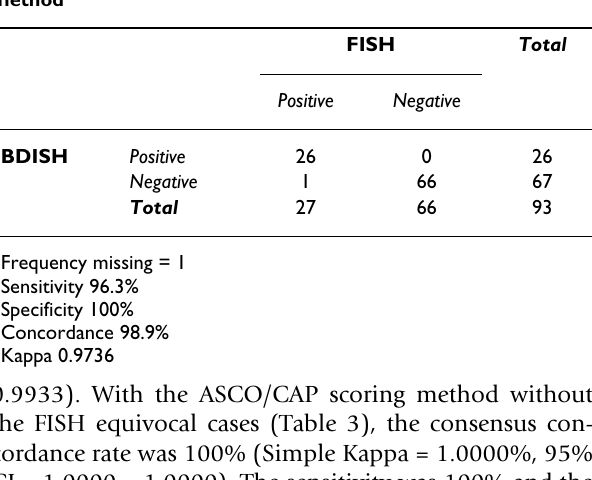
Table 1: Performance of brightfield double in situ hybridization (BDISH) with clinical samples based on the historic scoring method